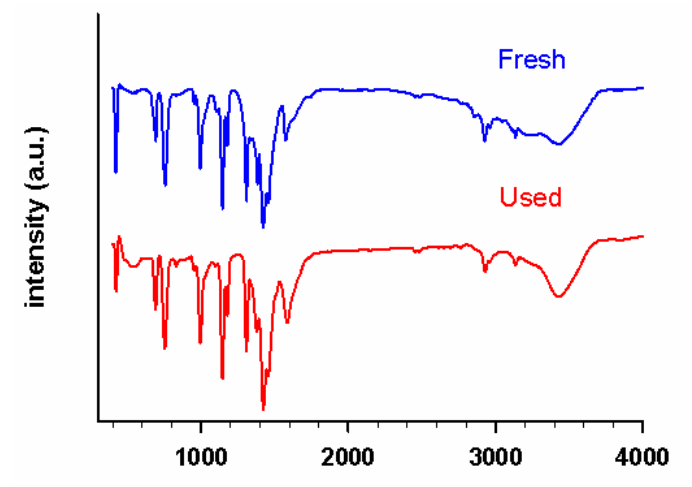
Fig. 15. FT-IR analysis of fresh and spent Fe-ZIF-8